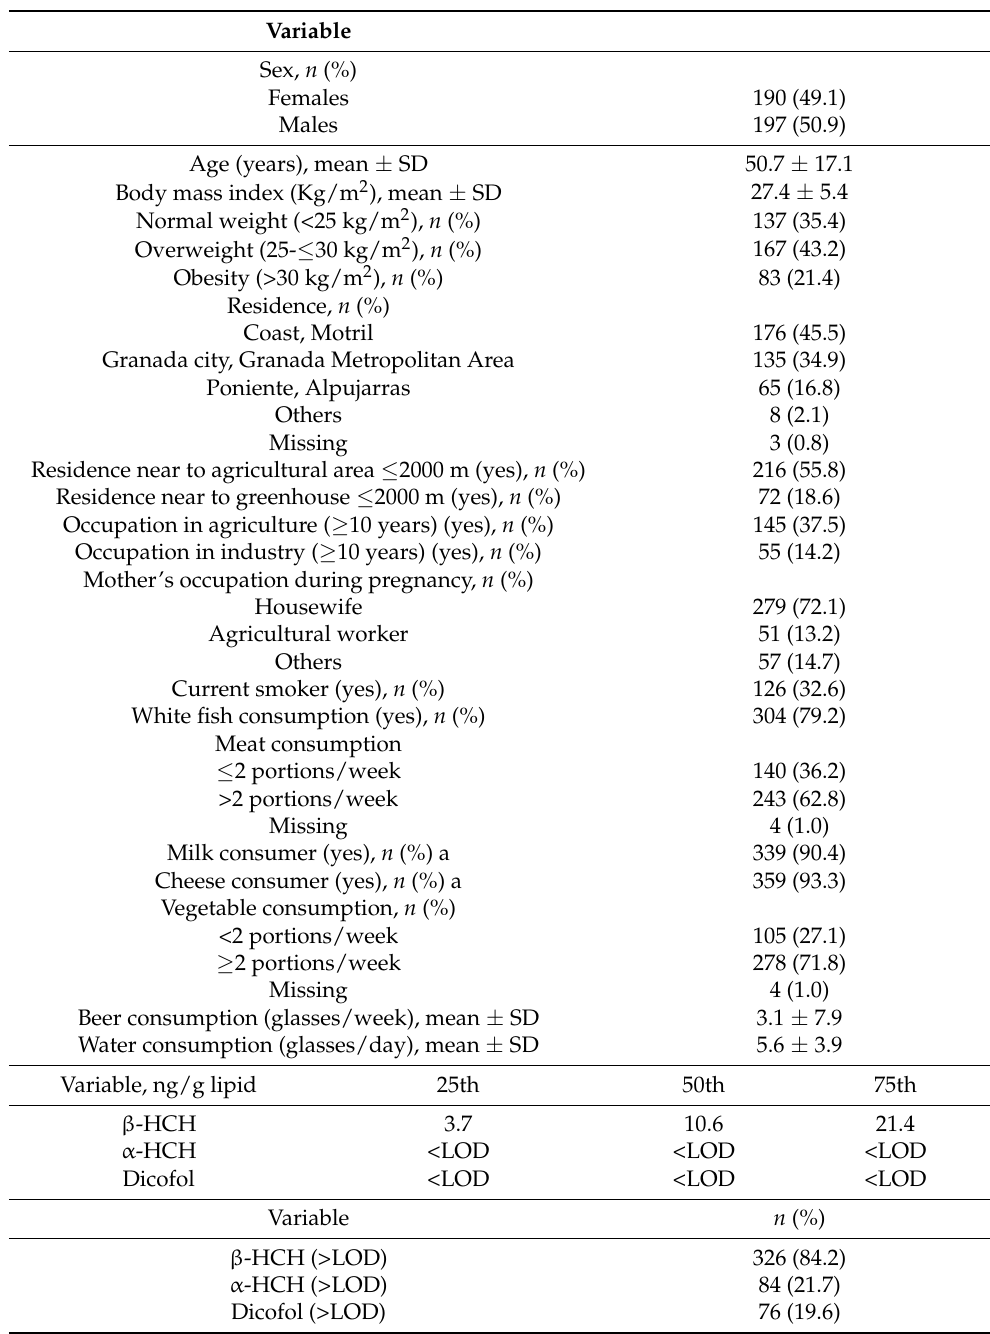
Table 1. Characteristics of the study population ( n =